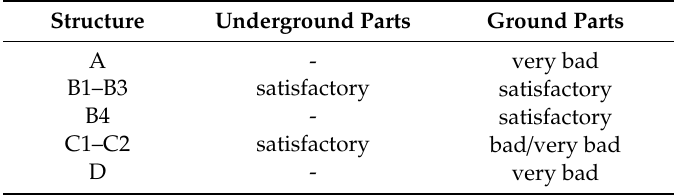
Table 4. Results of identified technical